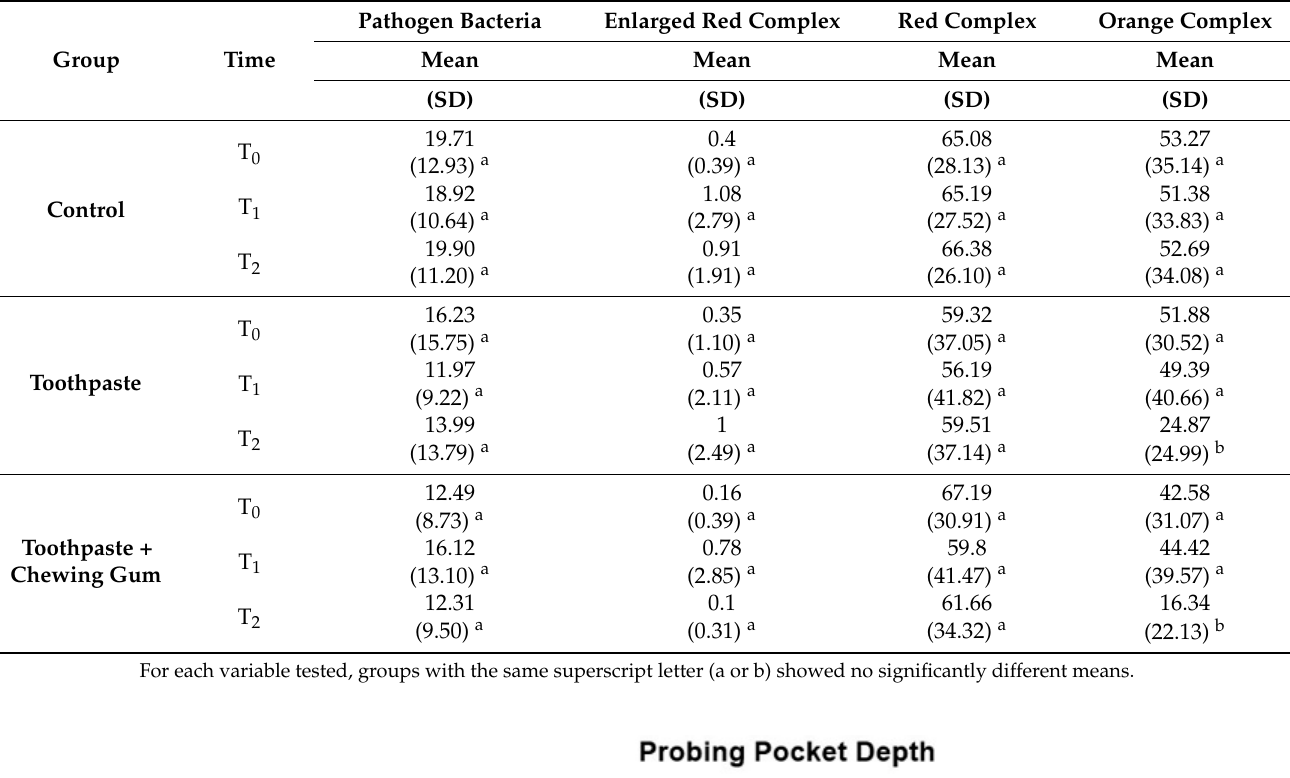
Table 5. Descriptive statistics of microbiological parameters (2).